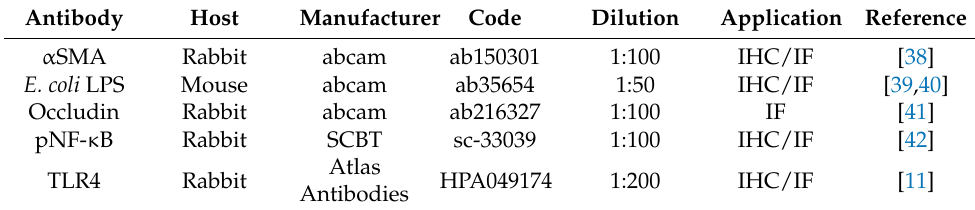
Table 1. List of primary